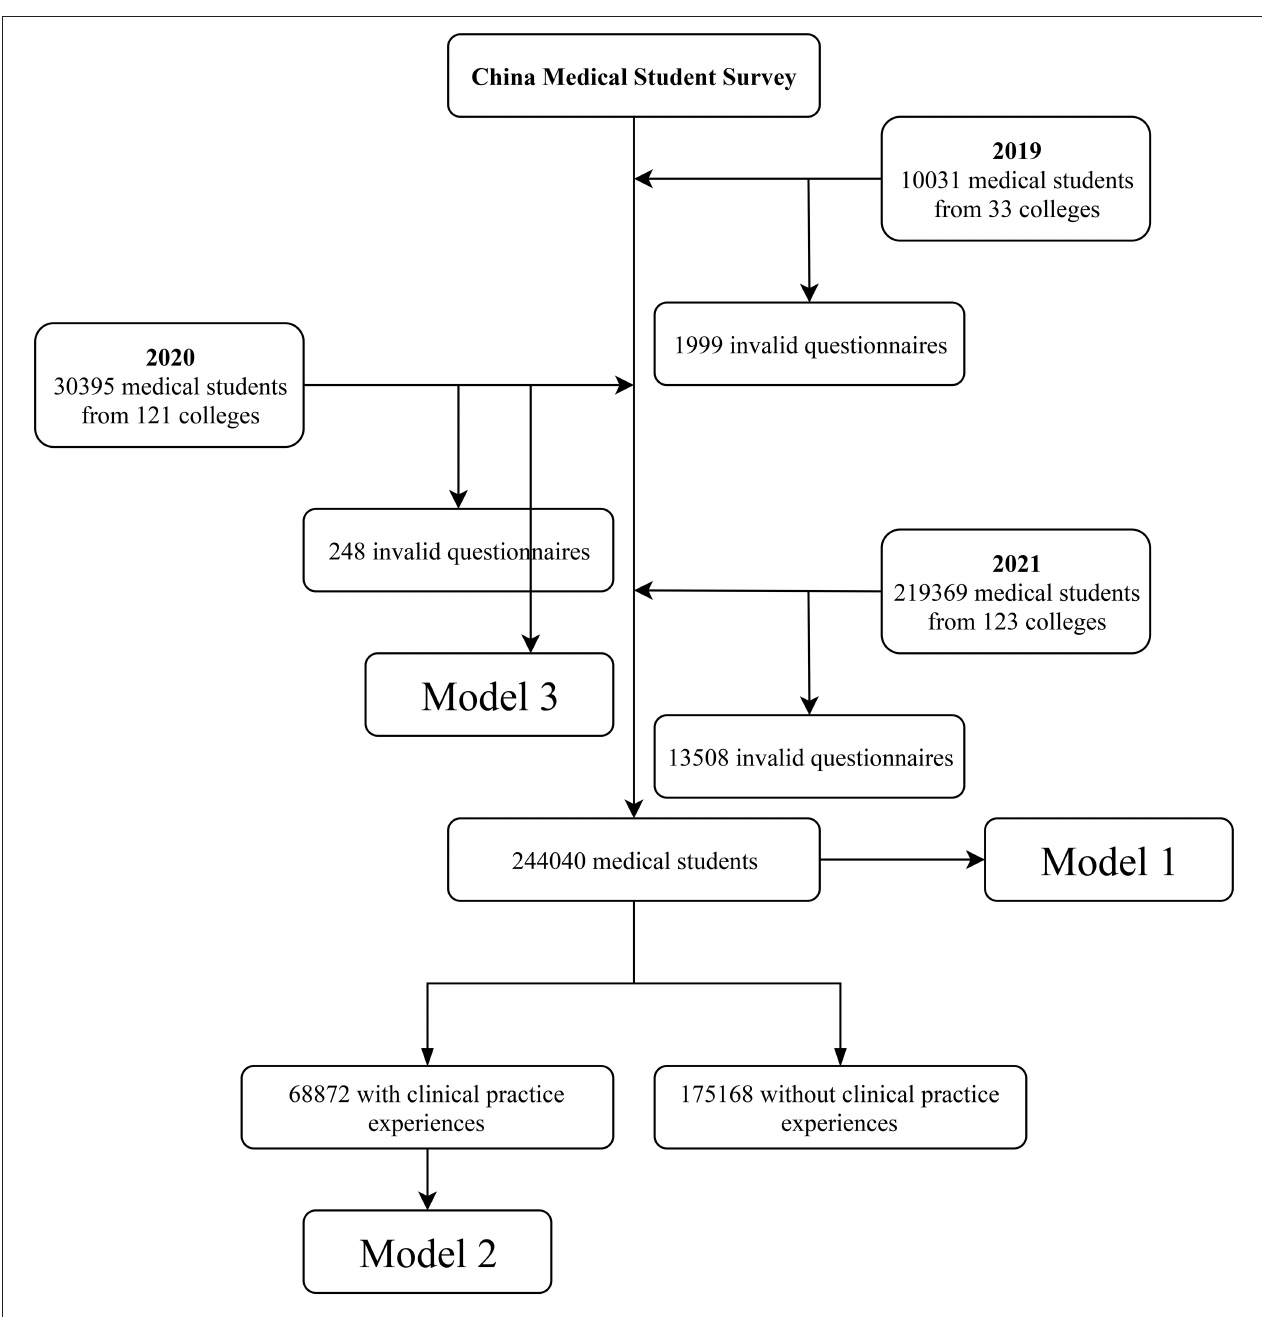
FIGURE 1 | Flowchart of participants